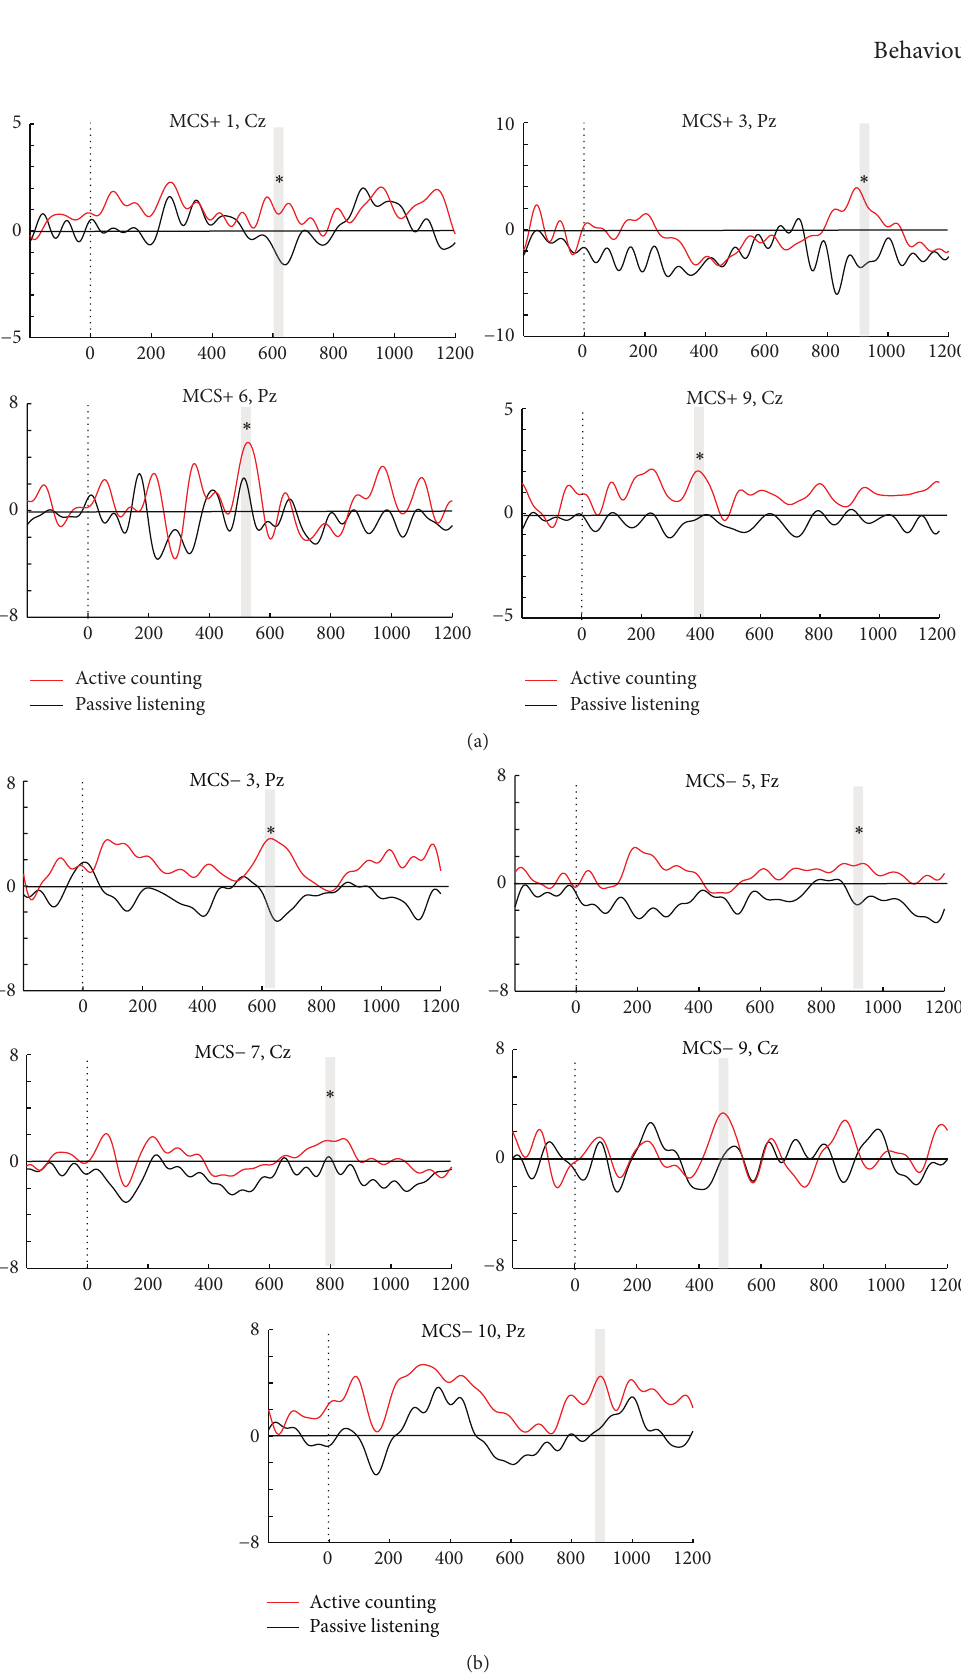
Figure 5: Individual patients considered responders in the active counting condition of task 2. (a) Illustrates ERPs in individual MCS+ responders in task 2, while (b) provides ERPs in individual MCS − responders. The averaged ERPs in the active counting (red) versus passive (black) condition ( 𝑦 -axis, amplitude in 𝜇 V; 𝑥 -axis, time in ms) are illustrated. Observed significant differences of P3 amplitude between conditions ( 𝑝 values < .05 to .001) are marked with a star above the P3 curve marked with grey